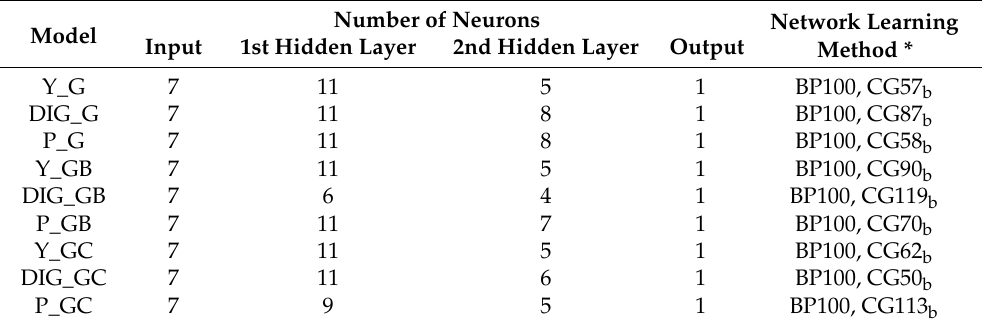
Table 3. The structures of neural networks in the deterministic models and the learning methods. Number of Neurons Network Model